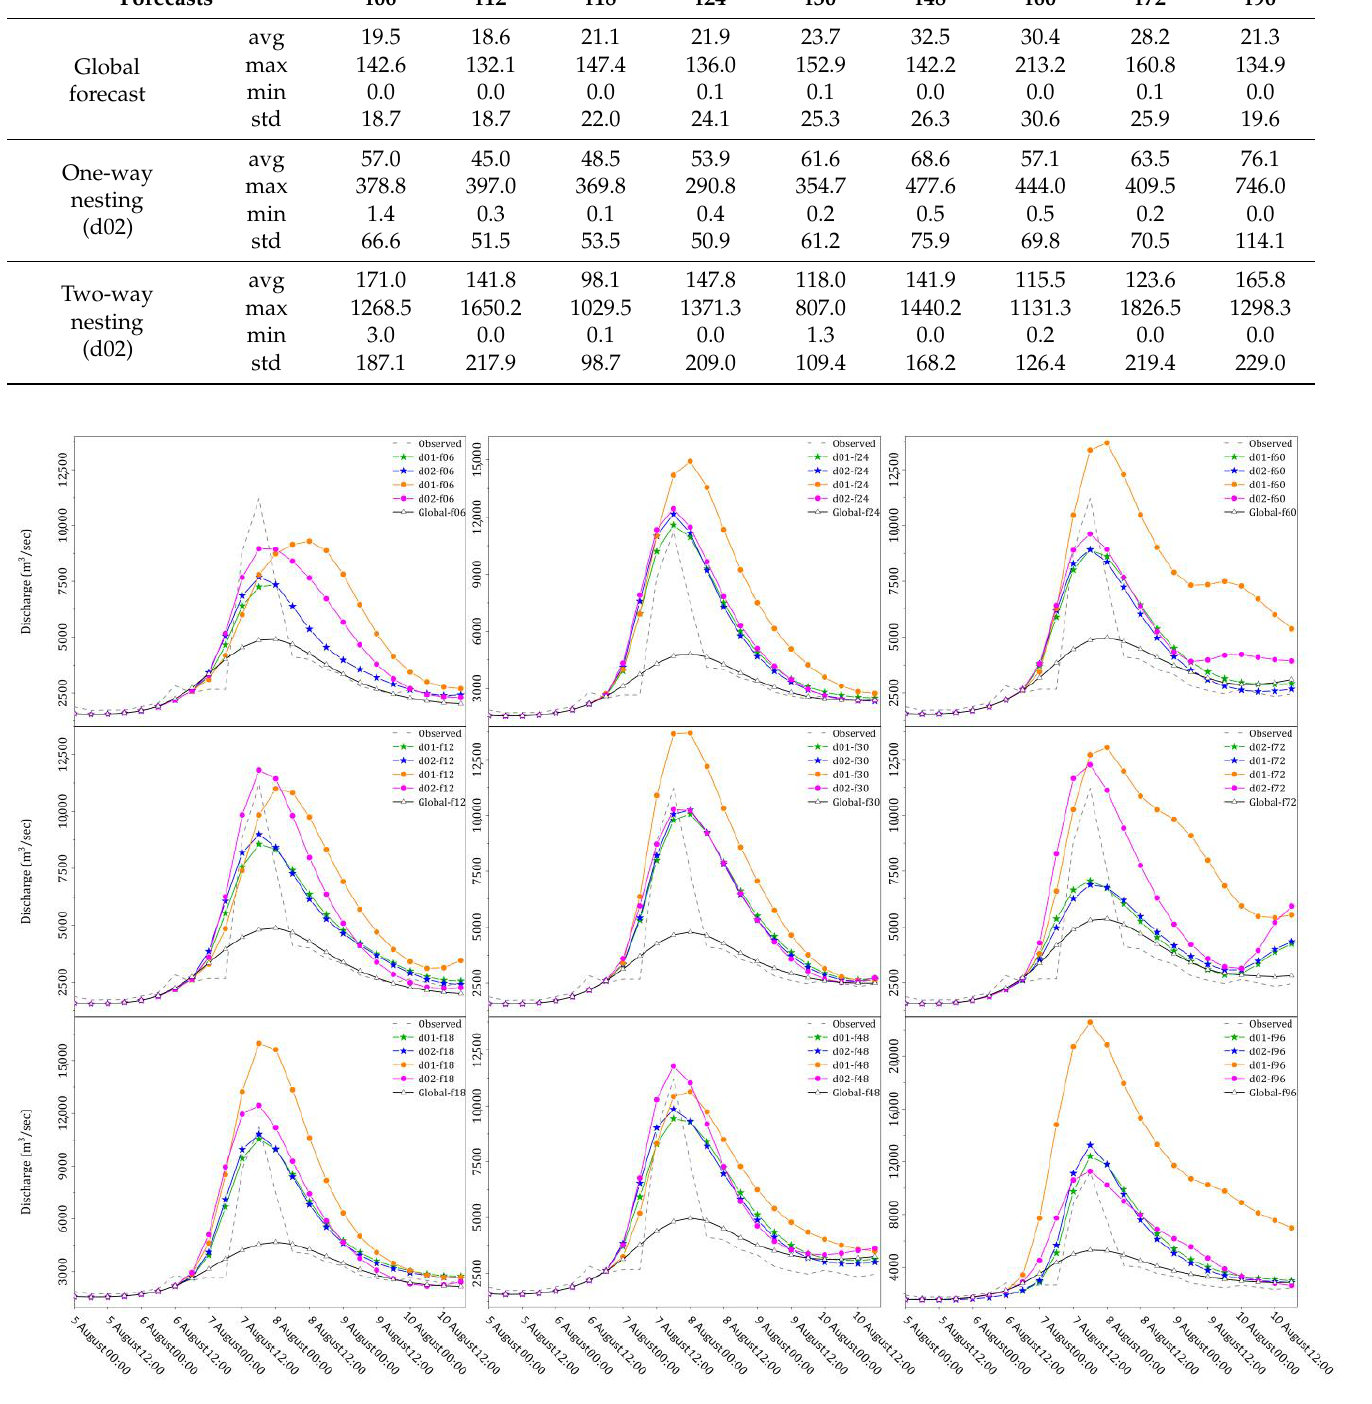
Figure 6. Observed vs simulated flood hydrographs driven by different precipitation sources and different initial forecasts times (i.e., f06, f12, f18, f24, f30, f48, f60, f72, and f96) for the 2016 event in the CRB. The circle symbol represents one-way nesting, and the star symbol represents two-way nesting.